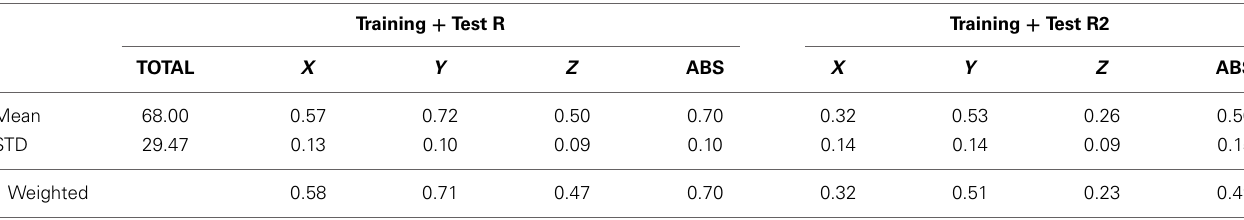
Correlation (R) and R 2 statistics in all the trials (both training and test sets) lumped together from all rats to show that the performance of the algorithm was comparable (and not superior) to that of test